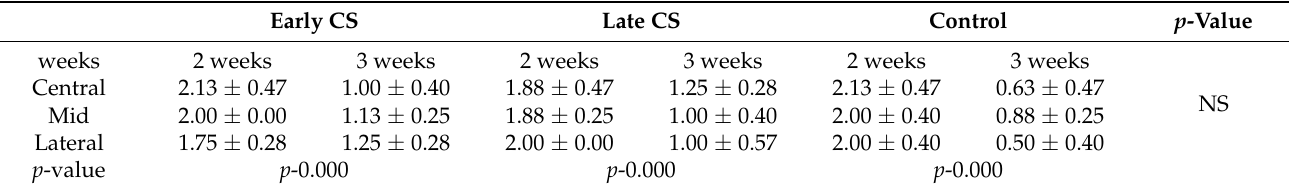
Table 2. Mean inflammation score at two and three weeks.